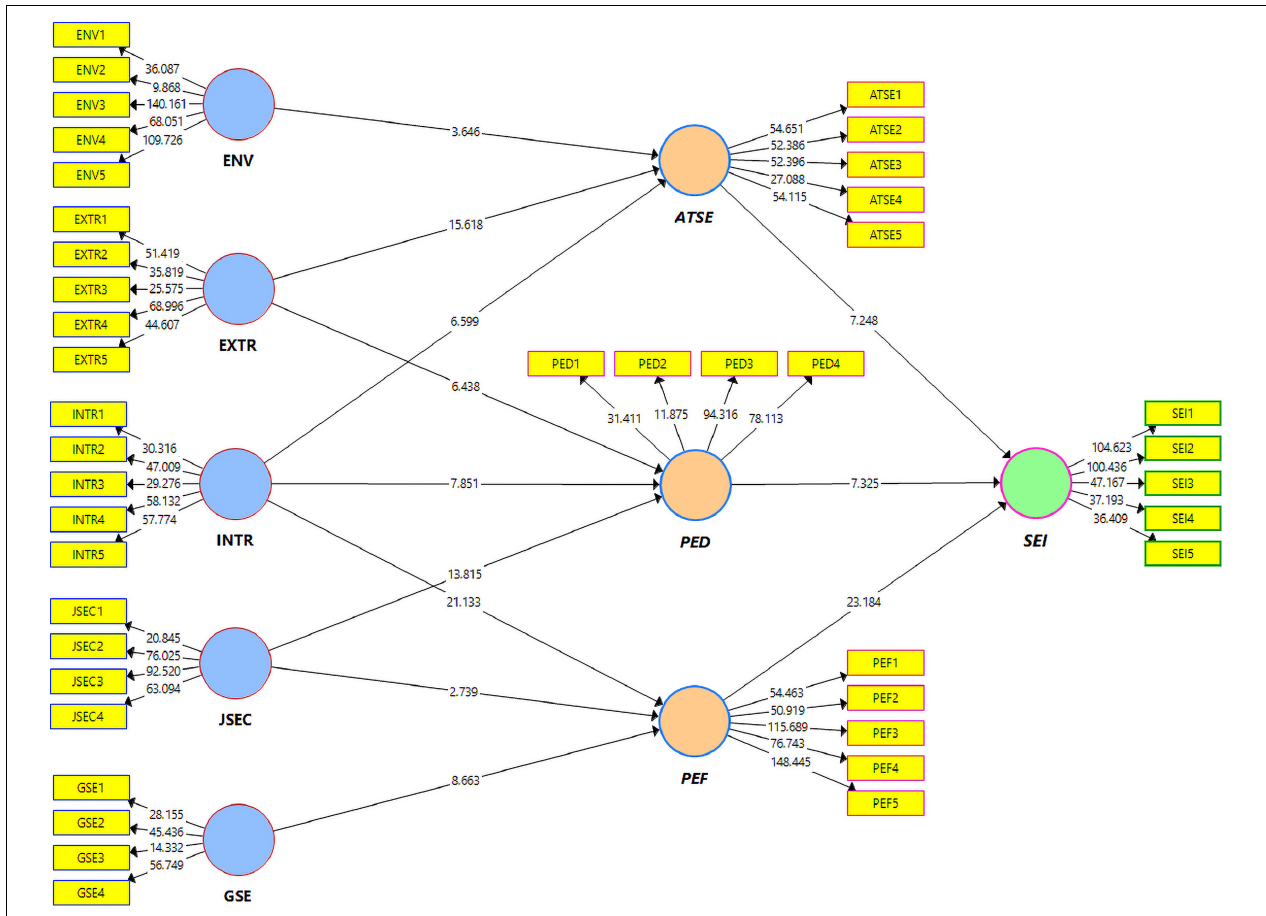
FIGURE 4 | Direct and indirect significant relationships of total sample model. TABLE 9 | Total indirect effects among the constructs of China vs. Pakistan.